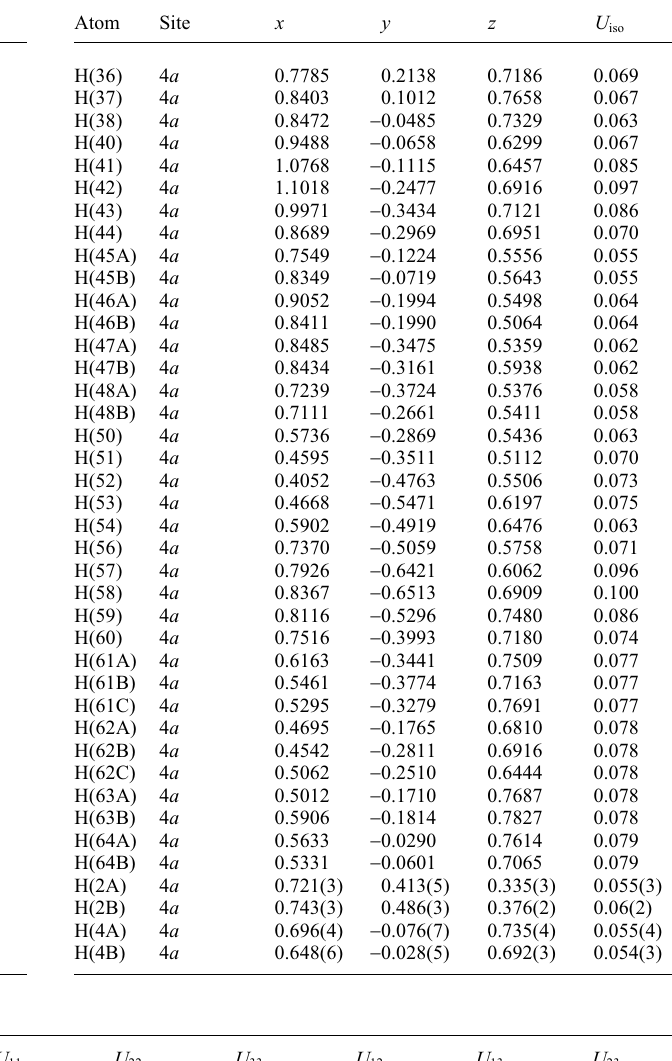
Table 2. Atomic coordinates and displacement parameters (in Å 2 )